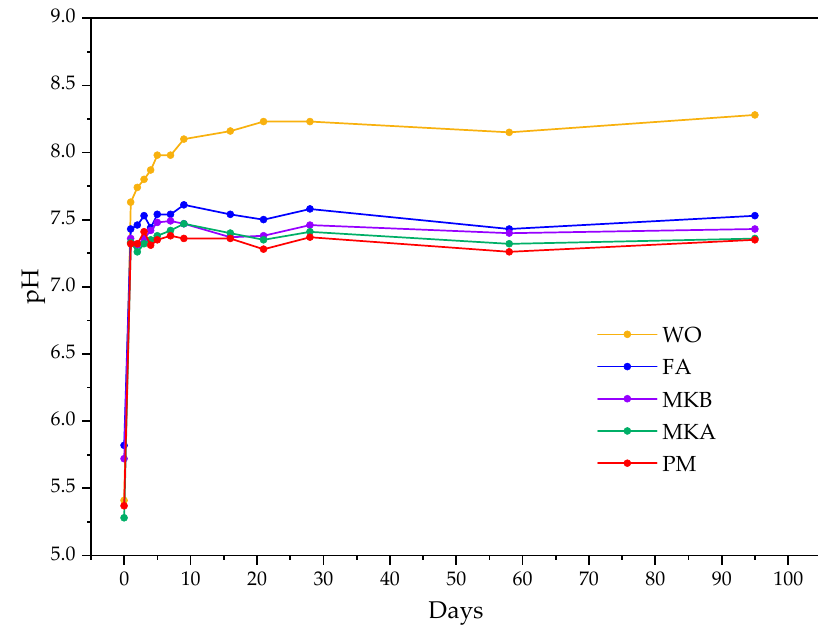
Figure 4. pH of MKPC paste suspensions with a solid/liquid ratio of 1:1.